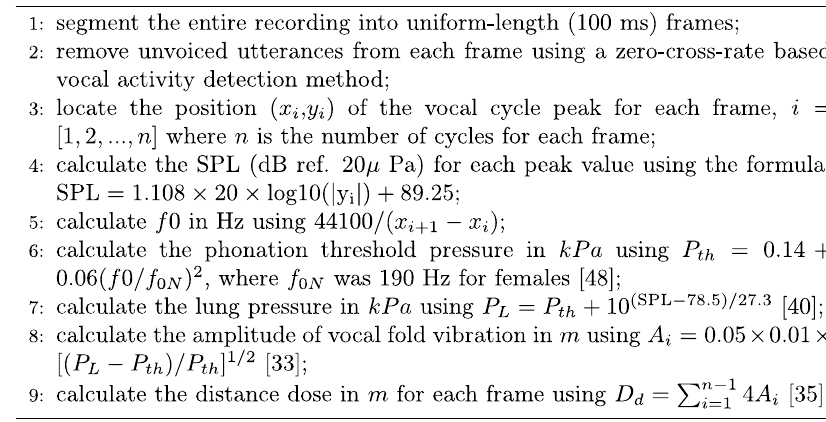
Figure 3. Procedure for the 20 s distance dose